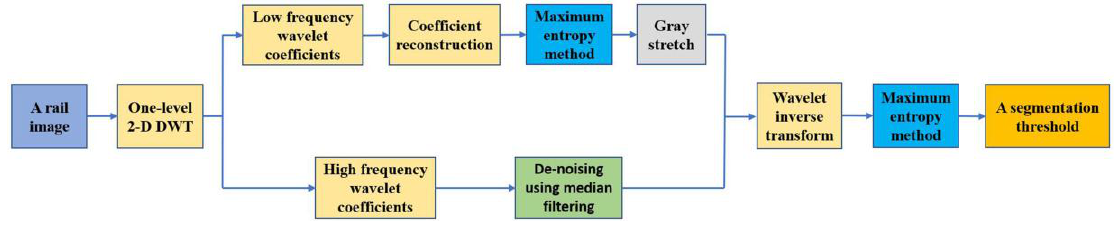
Figure 6. The procedure of the GSME method.